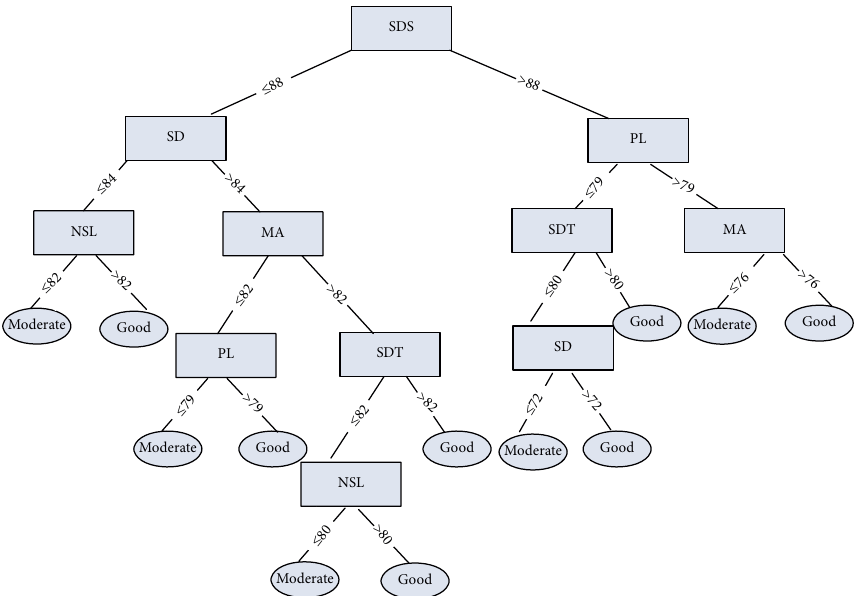
Figure 6: Decision tree by using C4.5